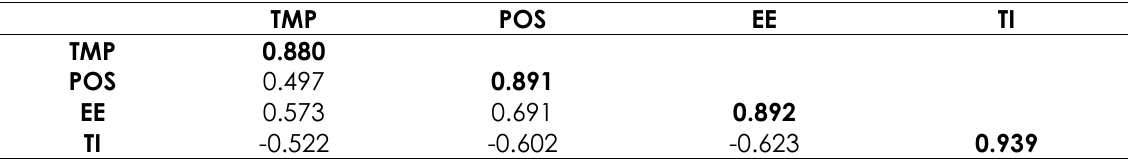
Fornell-Larcker Criterion